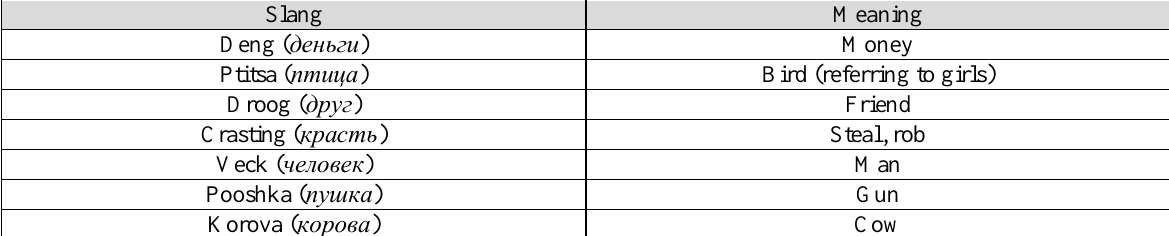
Table 2 – Slang in A Clockwork Orange